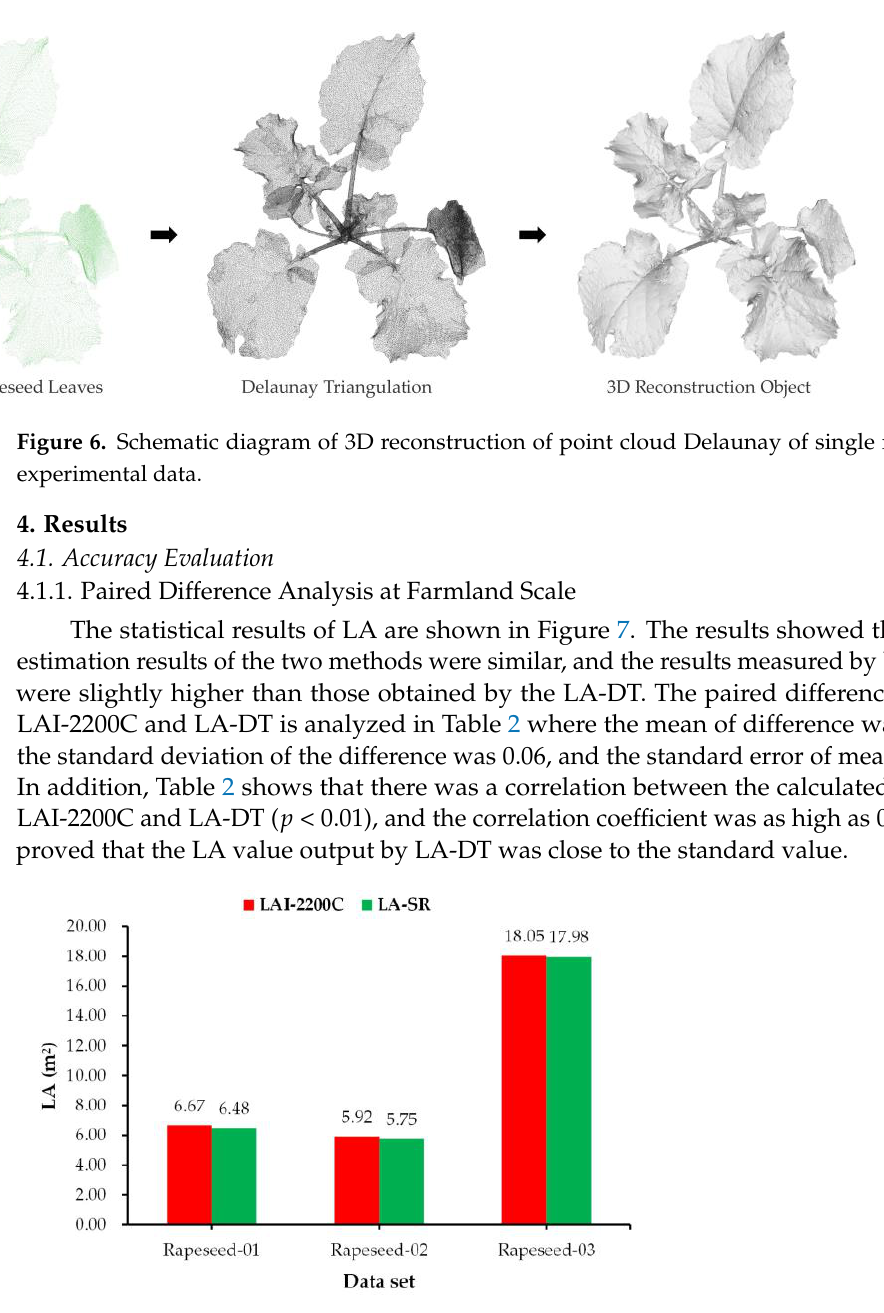
Figure 6. Schematic diagram of 3D reconstruction of point cloud Delaunay of single rapeseed in experimental data.